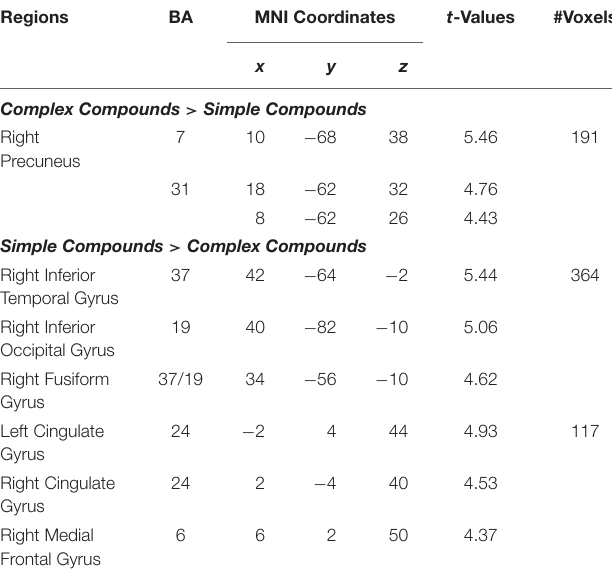
Clusters identified by analyses comparing activation between Simple and Complex Compounds (clusters consisting of > 100 contiguous voxels at a threshold of p < 0.005).